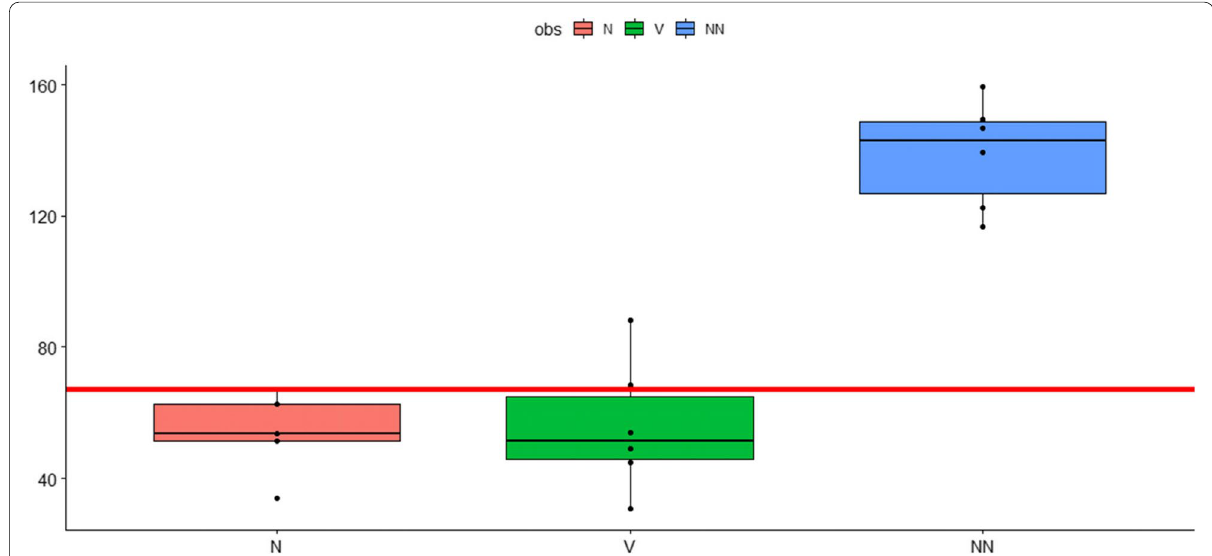
Fig. 2 Maximal Oxygen Consumption Rates (OCR). Maximal OCR in pmol O 2 /min were measured before, after the first 10-pass OHT and after the second 10-pass OHT one week later. Cumulative data from six patients expressed as mean V); 0,0,000,471 (N versus NN). COHEN: 4.540905 (NN versus V); 0,1,249,093 (N versus V); 5,725,858 (N versus NN). ANOVA: 0,0,000,019 (NN versus V); 0,9,760,742 (N versus V); 0,00,000,024 (N versus NN). V: before OHT; N: after the first OHT; NN: after the 2. OHT (one week later). Y-Axis: pmol O2/min; X-axis: sampling time